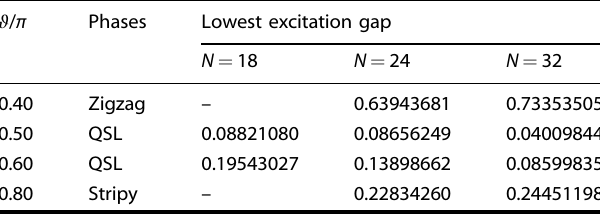
Table 1. Lowest excitation gap on hexagonal